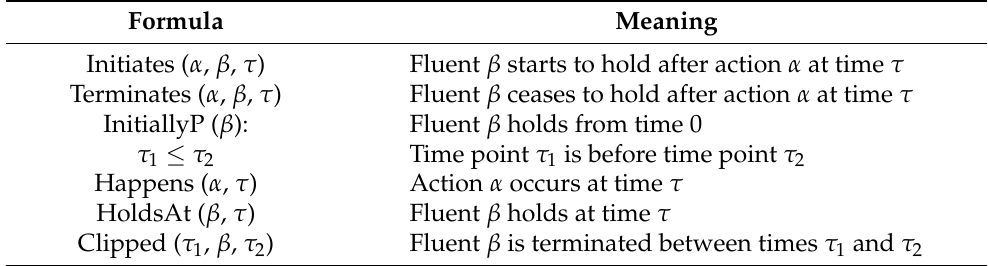
Table 5. Shanahan’s event calculus formulas.